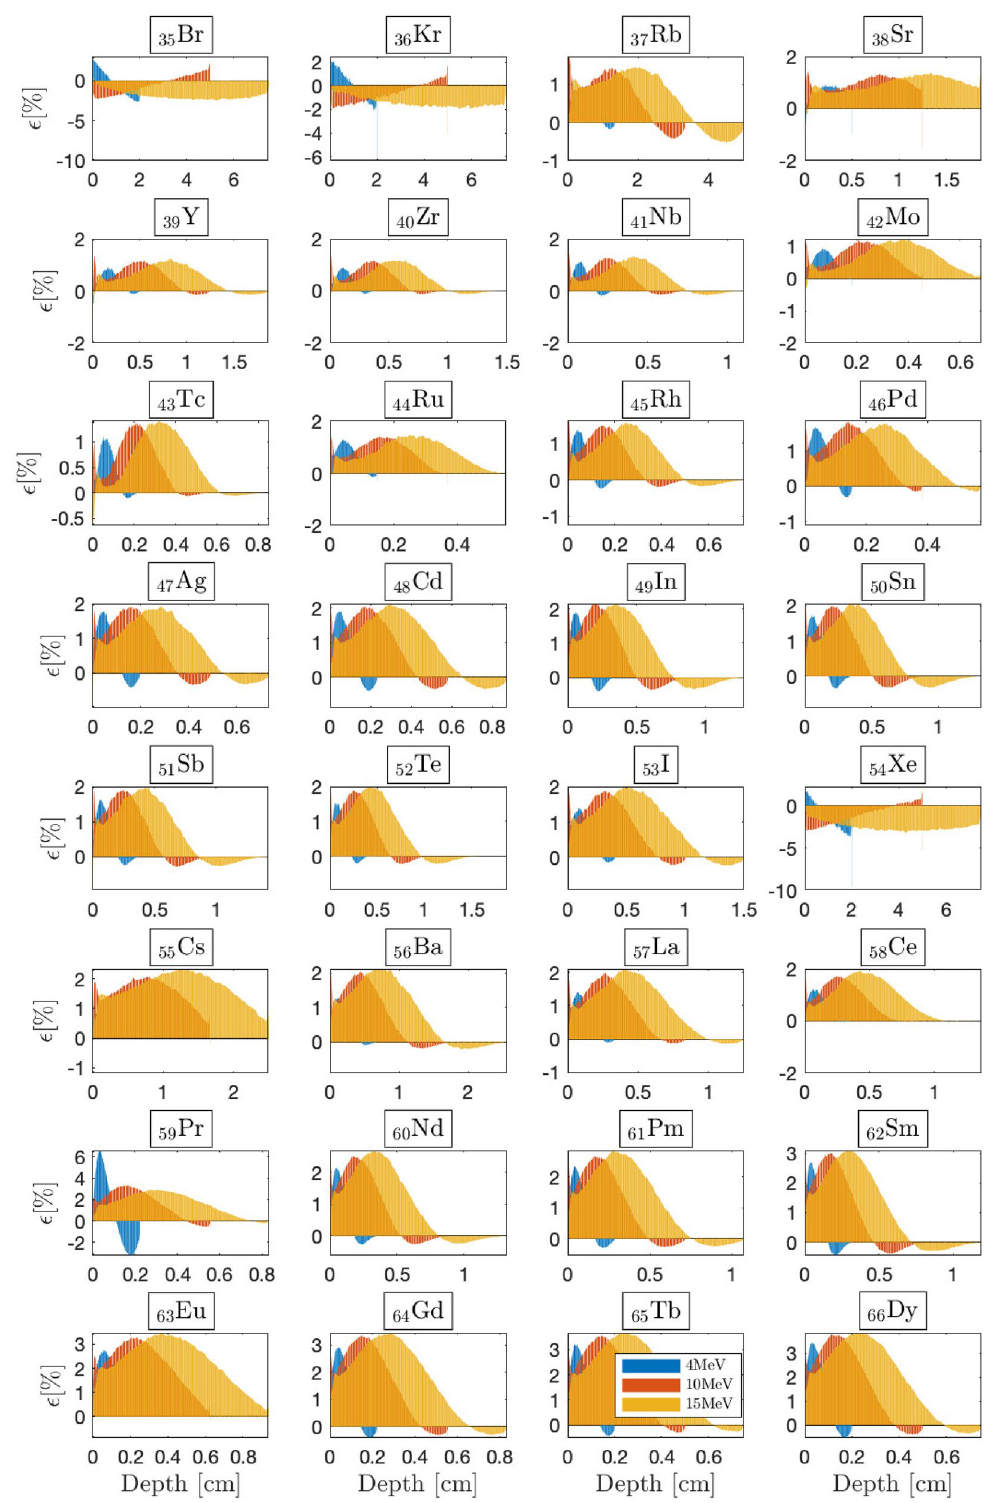
Figure 6. BFP-MC relative differences in energy deposition profiles versus depth for selected 4, 10 and 15 MeV beams from Z = 35 to Z = 66 . The irradiated slabs’ dimensions are fixed to the beam’s range within the irradiated material. Monte Carlo convergences are obtained for a 0.2% mean standard